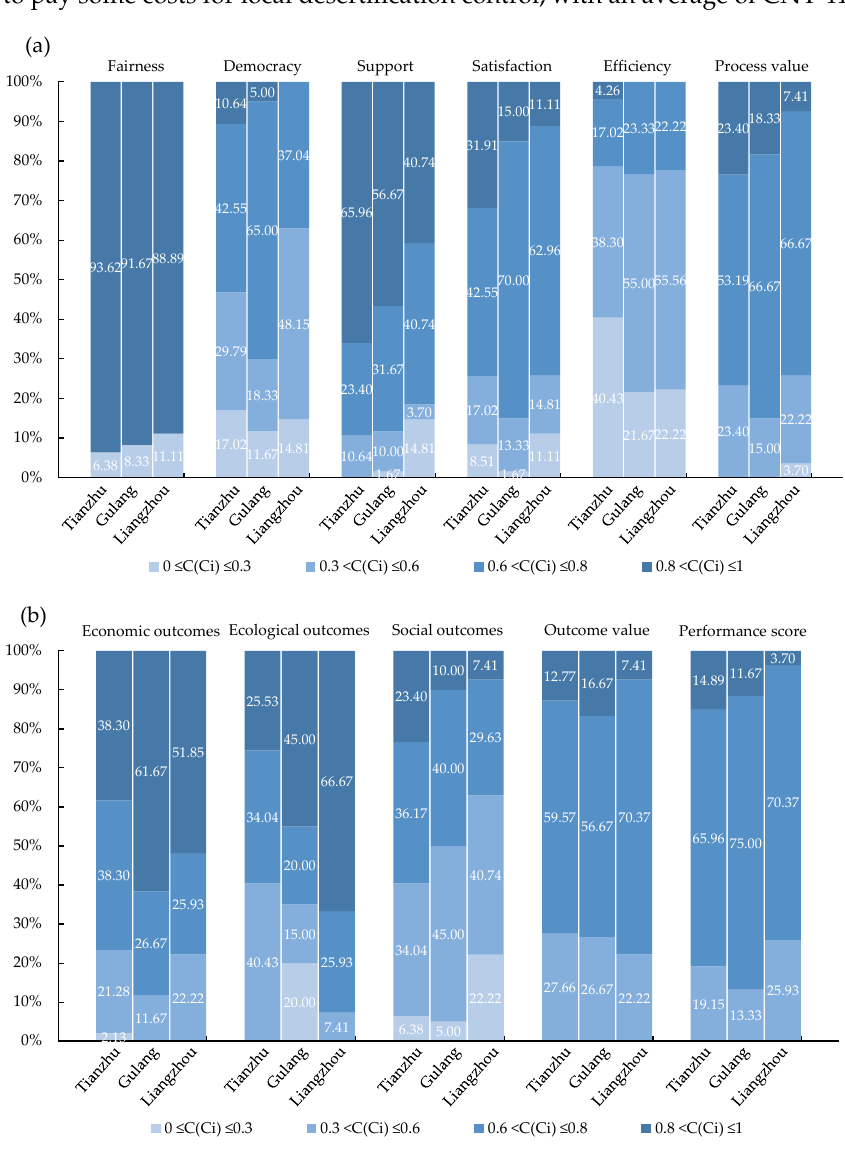
Figure 8. Distribution of performance value of ERP in different spaces. ( a ) indicate that the distribution of average closeness of five sub-components in process dimension. ( b ) indicate that the distribution of average closeness of outcome dimension. Note: Ci indicates the average closeness of each component; C indicates the average closeness of performance value of ERP.